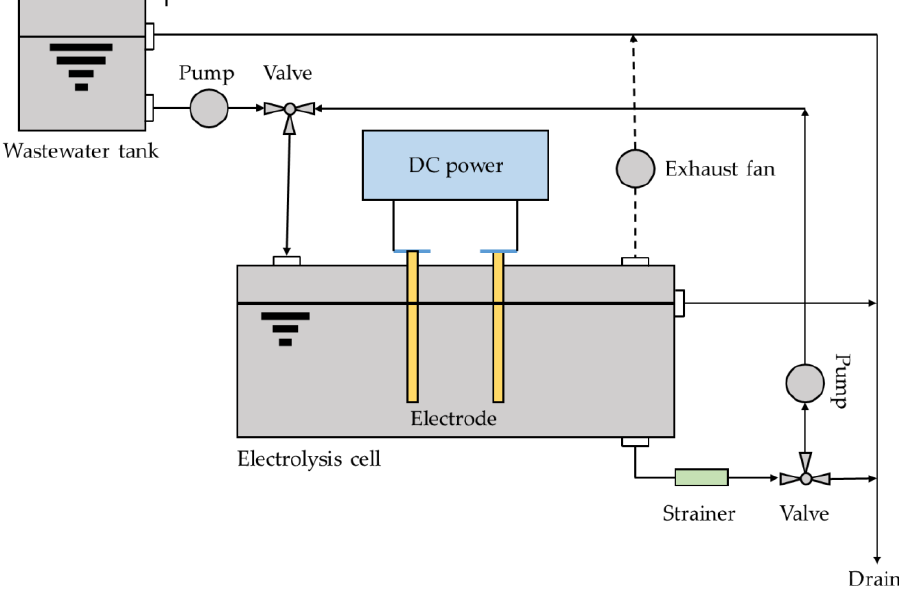
Figure 6. Schematic representation of electrolysis apparatus. The chloride ion becomes free chlorine at the anode upon oxidation. Then free chlo- rine reacts with water, and hypochlorite ion is generated in alkaline solution. The gener- ated hypochlorite ion oxidizes antineoplastics and is reduced to the chloride ion. It is spec- ulated that chlorine reactivation in the circulating system is the main mechanism for inac- was evaluated with 26 clinical WW samples, including alkylating agents, antimetabolites, tion rate was above 90% [139].